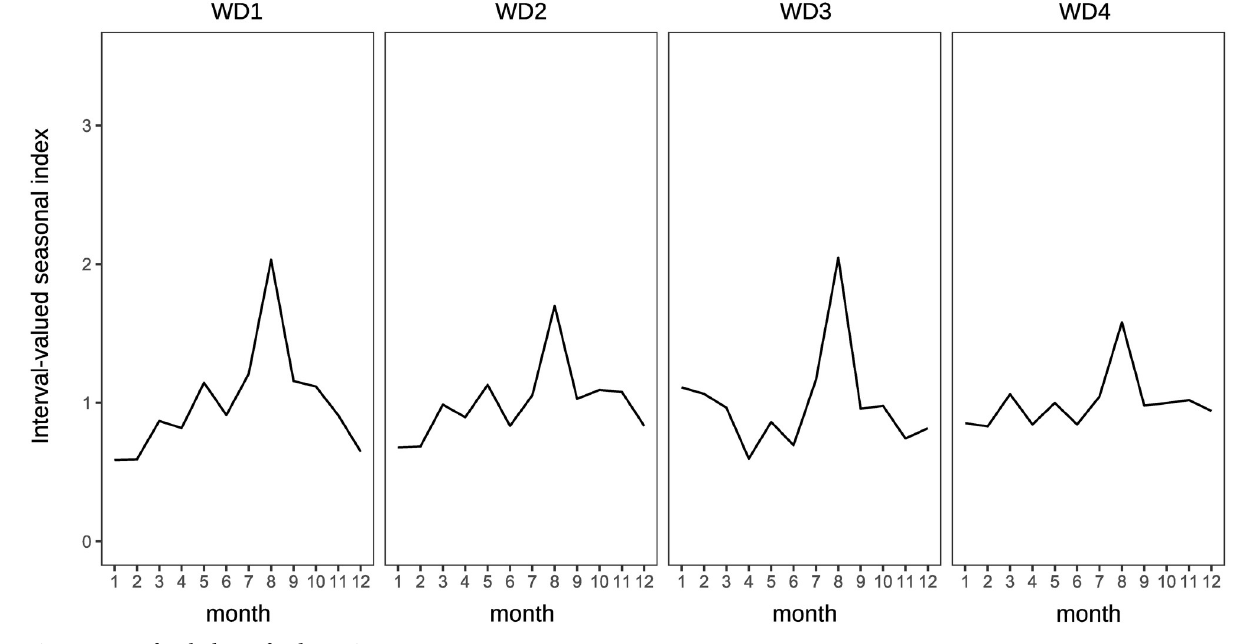
Fig 17. Mean of each cluster for domestic guests.